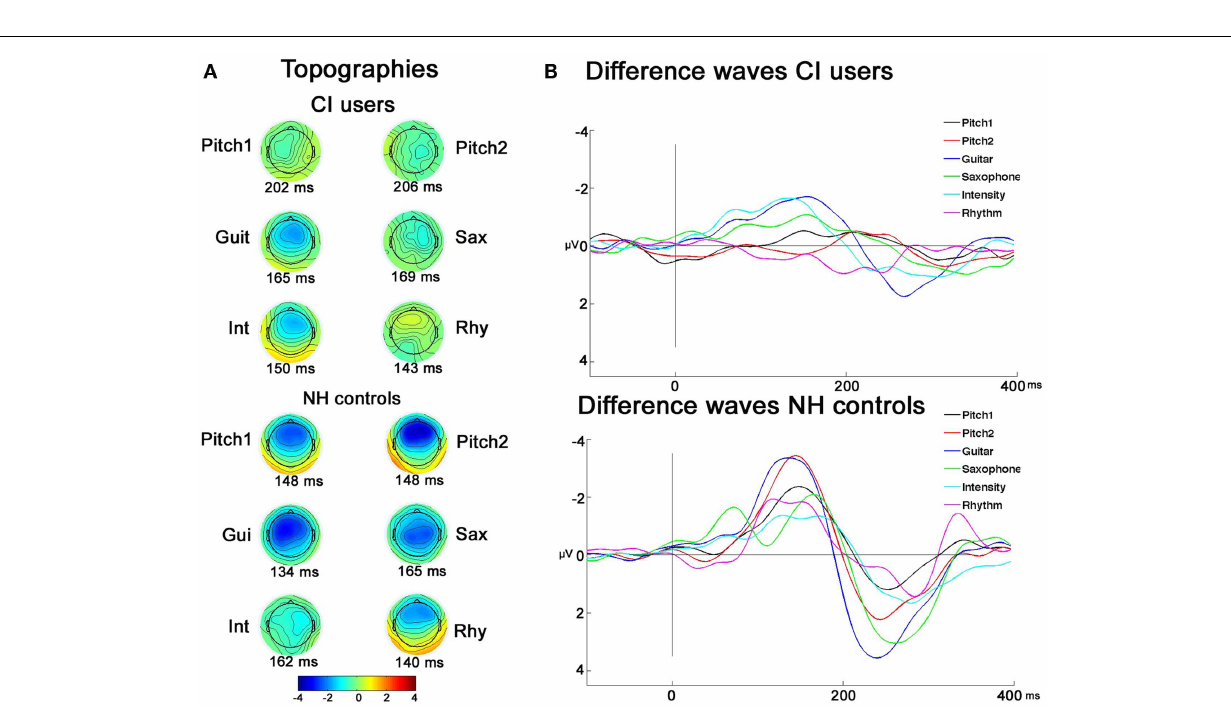
FIGURE 3 |Topographies and grand-average difference-waves of CI users and NH controls. (A) EEG voltage isopotential maps of the difference between the responses to deviants and standards averaged in an interval of ± 20ms around maximal peak amplitudes. (B) Grand-average difference-waves of CI users and NH